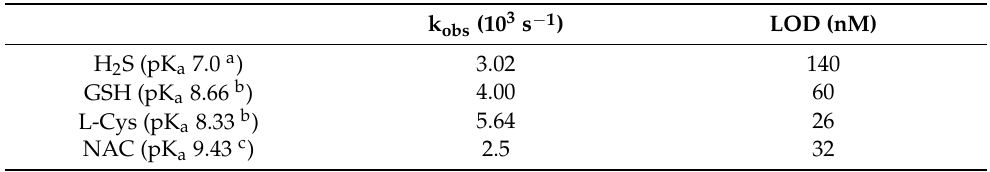
Figure 1. The time-dependent fluorescence intensity at 473 nm for NBD-O-CmCH 2 OH (5 μ M) in the absence or the presence of various thiol species (50 μ M) in PB buffer (0.1 M, pH 7.4, containing 10% MeCN, v/v ).